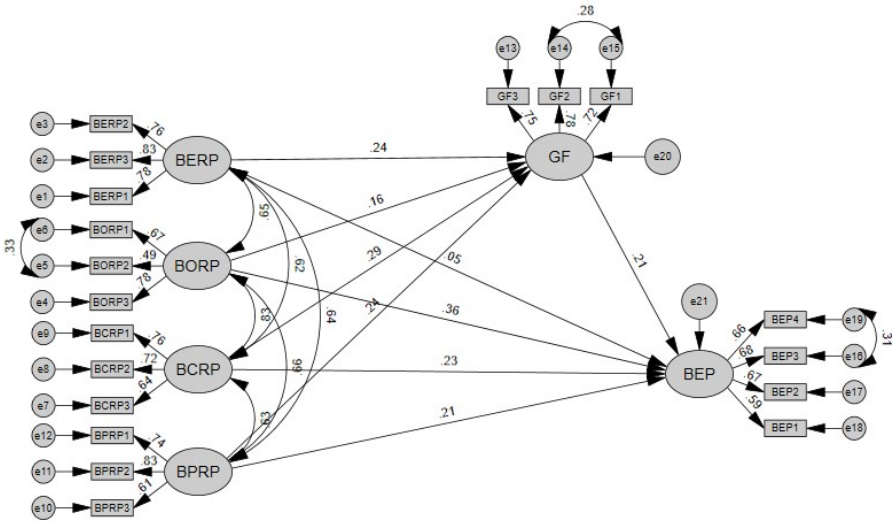
Figure 3. Structural model with standardized estimates. Note: BERP—banks’